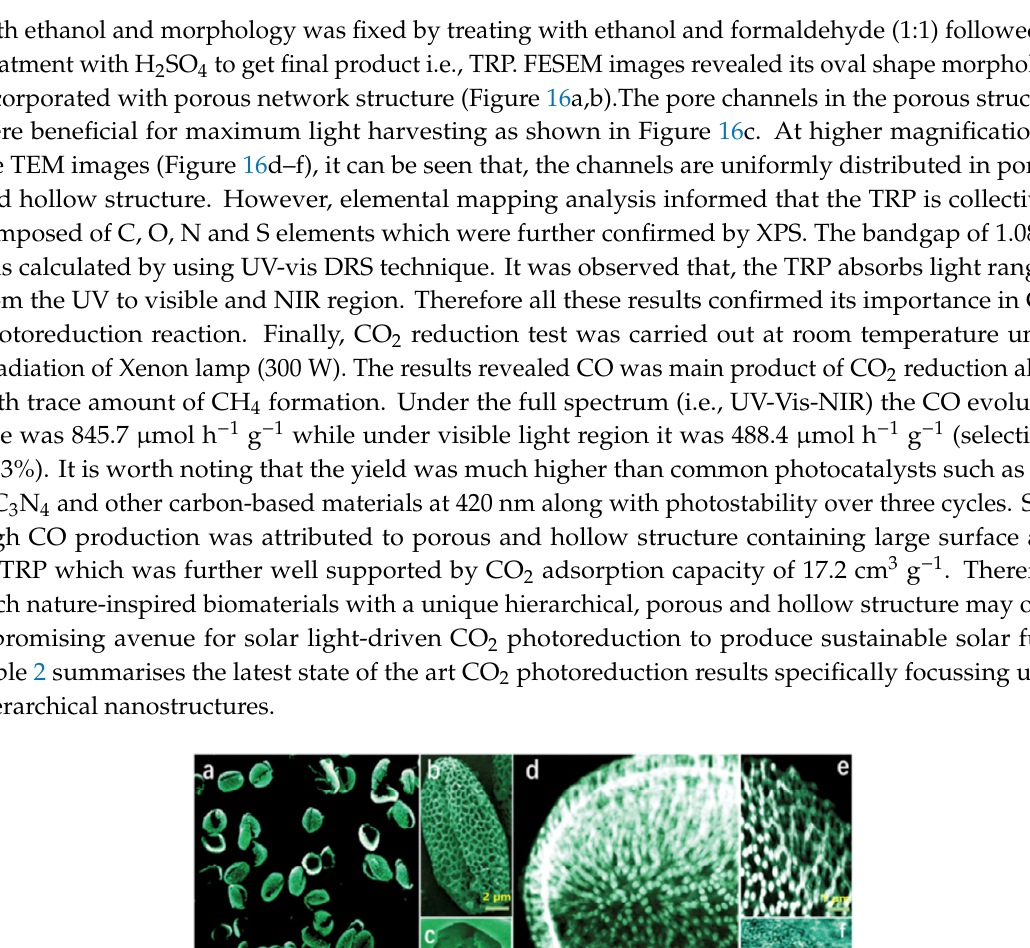
Table 2. Summary of hierarchical morphologies with specific examples of photocatalysts, CO 2 reduction parameters, and efficiency evaluation of different products along with their yield and apparent quantum yield (AQY). Hierarchical morphology Photocatalyst